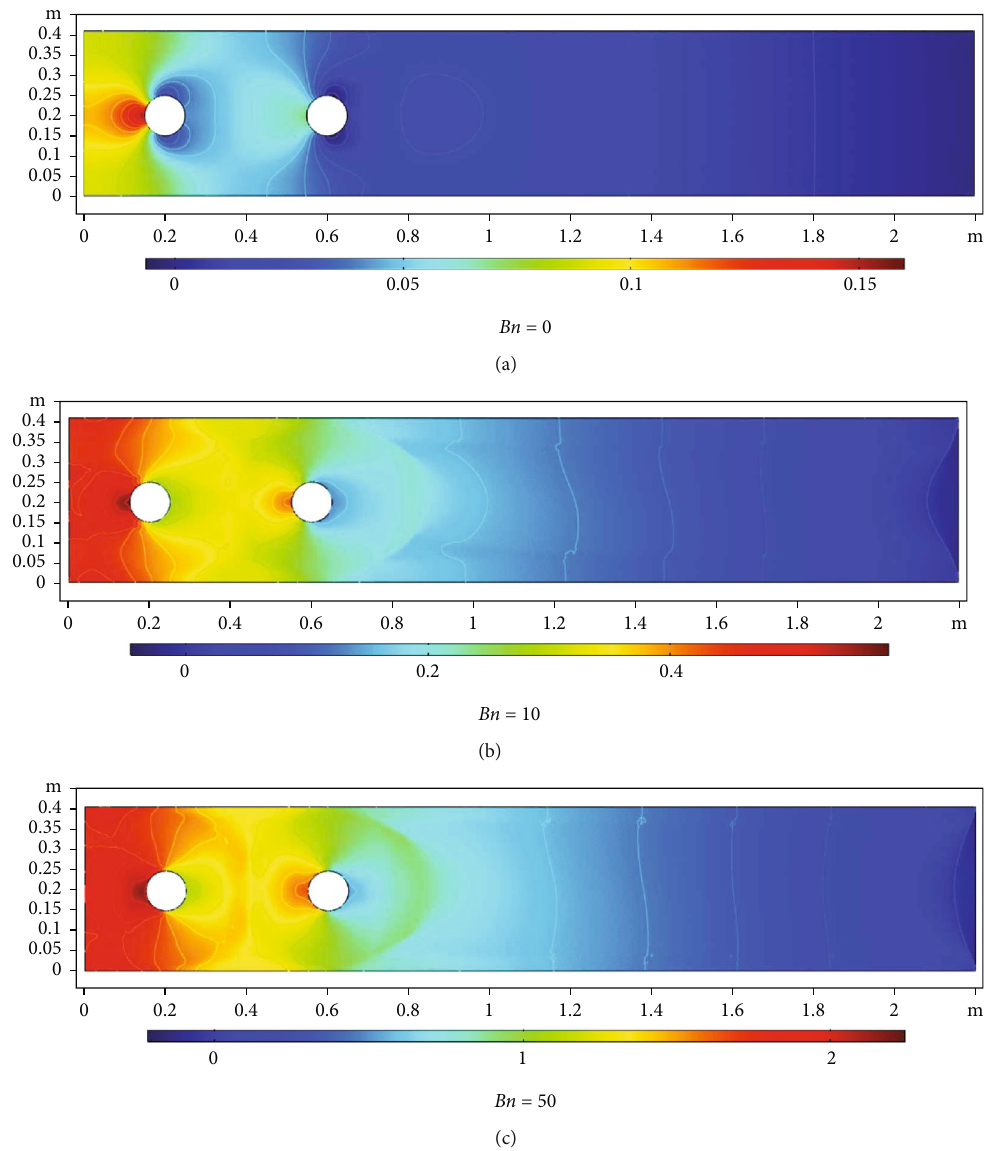
Figure 8: Pressure pro fi les for various Bn with G